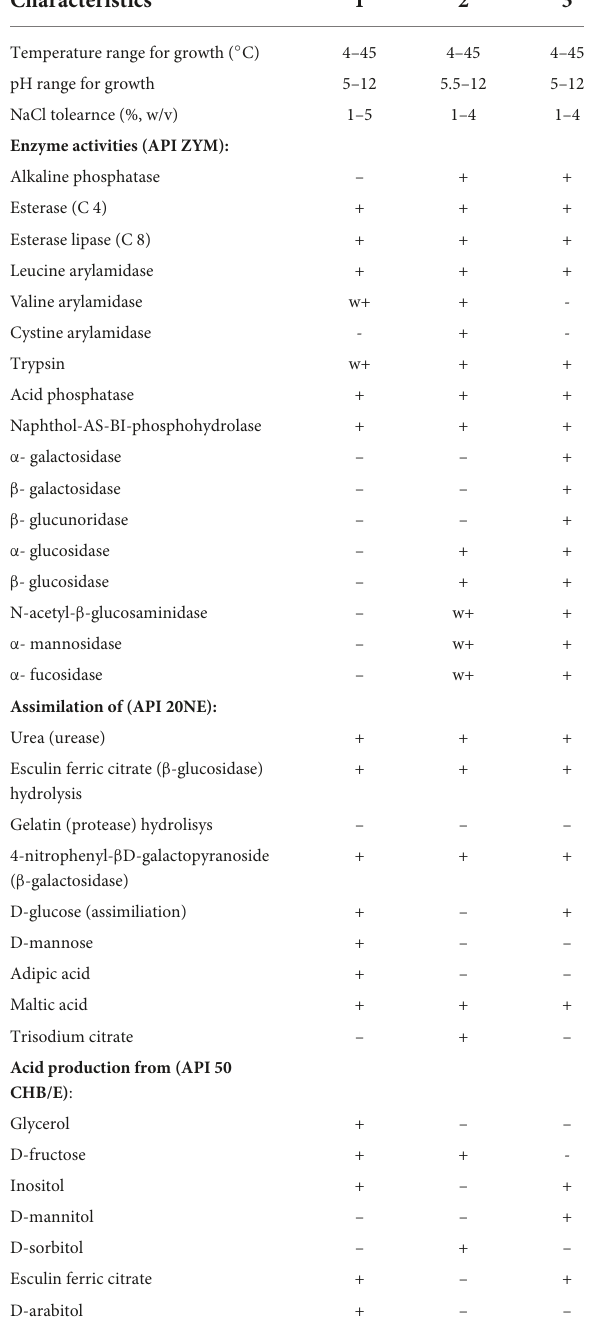
TABLE 1 Major phenotypic and biochemical characteristics of strain MAP12 T and other closely related type strains Strains: 1, MAP12 T ;